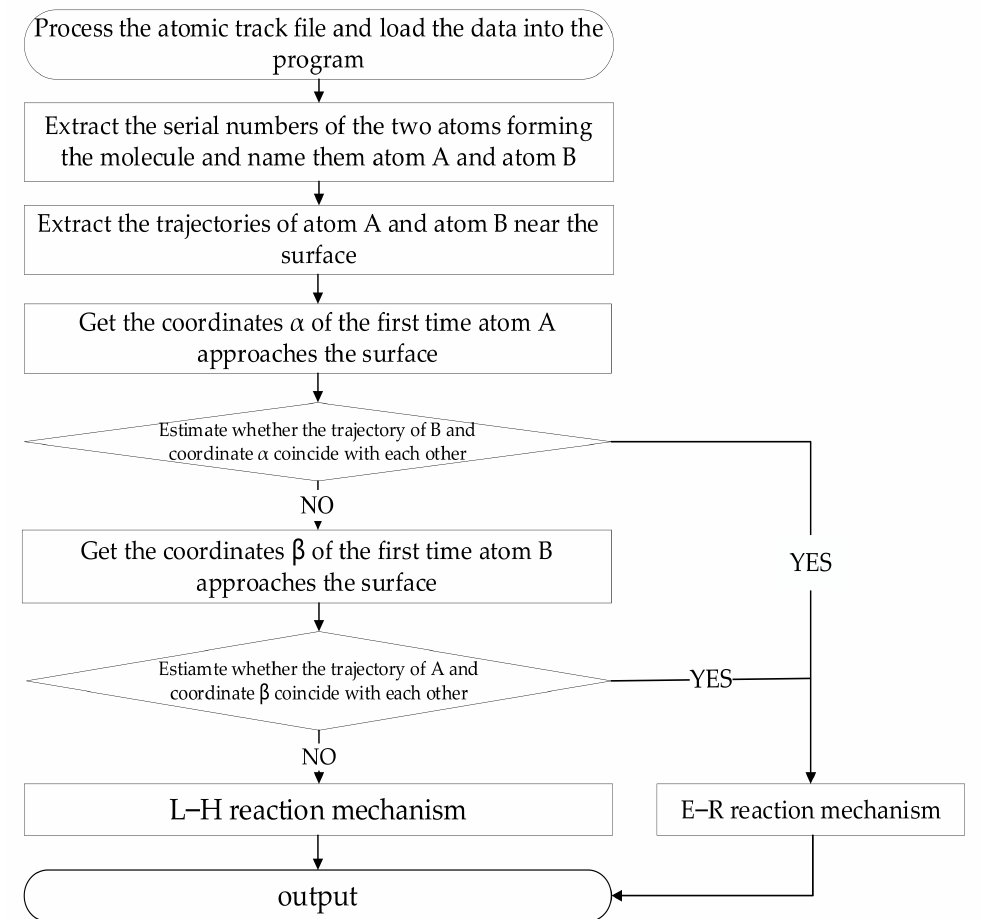
Figure 5. Statistical flow chart of surface catalysis recombination mechanism